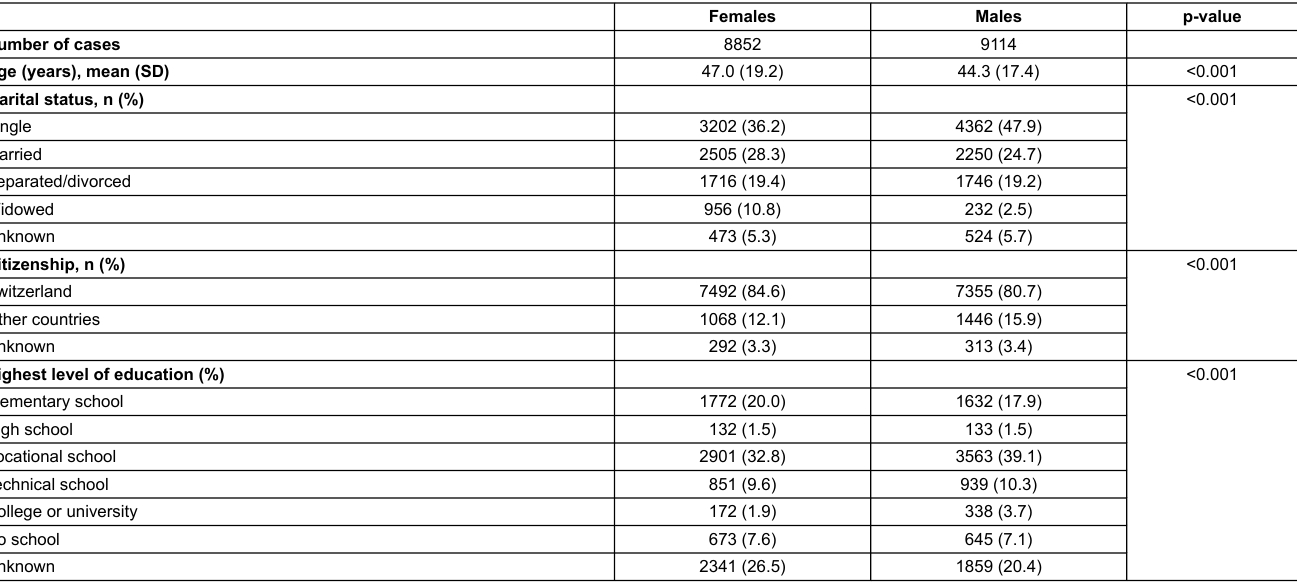
Table 1: Sociodemographic patient